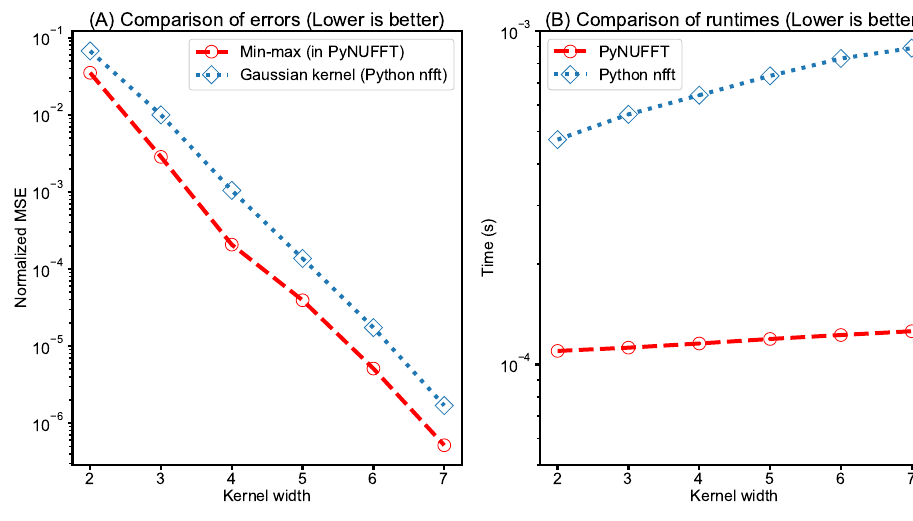
Figure 11. ( A )Theerrorsofthemin–maxinterpolator(inPyNUFFT)andtheGaussiankernel(in Python nfft). The parameters are: one-dimensional (1D) case, 1000 non-uniform locations, grid size = 256, oversampling factor = 2, FFT size = 512. ( B ) The runtimes of PyNUFFT and Python nfft on a single CPU core (Intel Core i7 6700HQ at 3500 MHz, 16 GB system memory). The Numpy was compiled with FFTW3 in the tests.